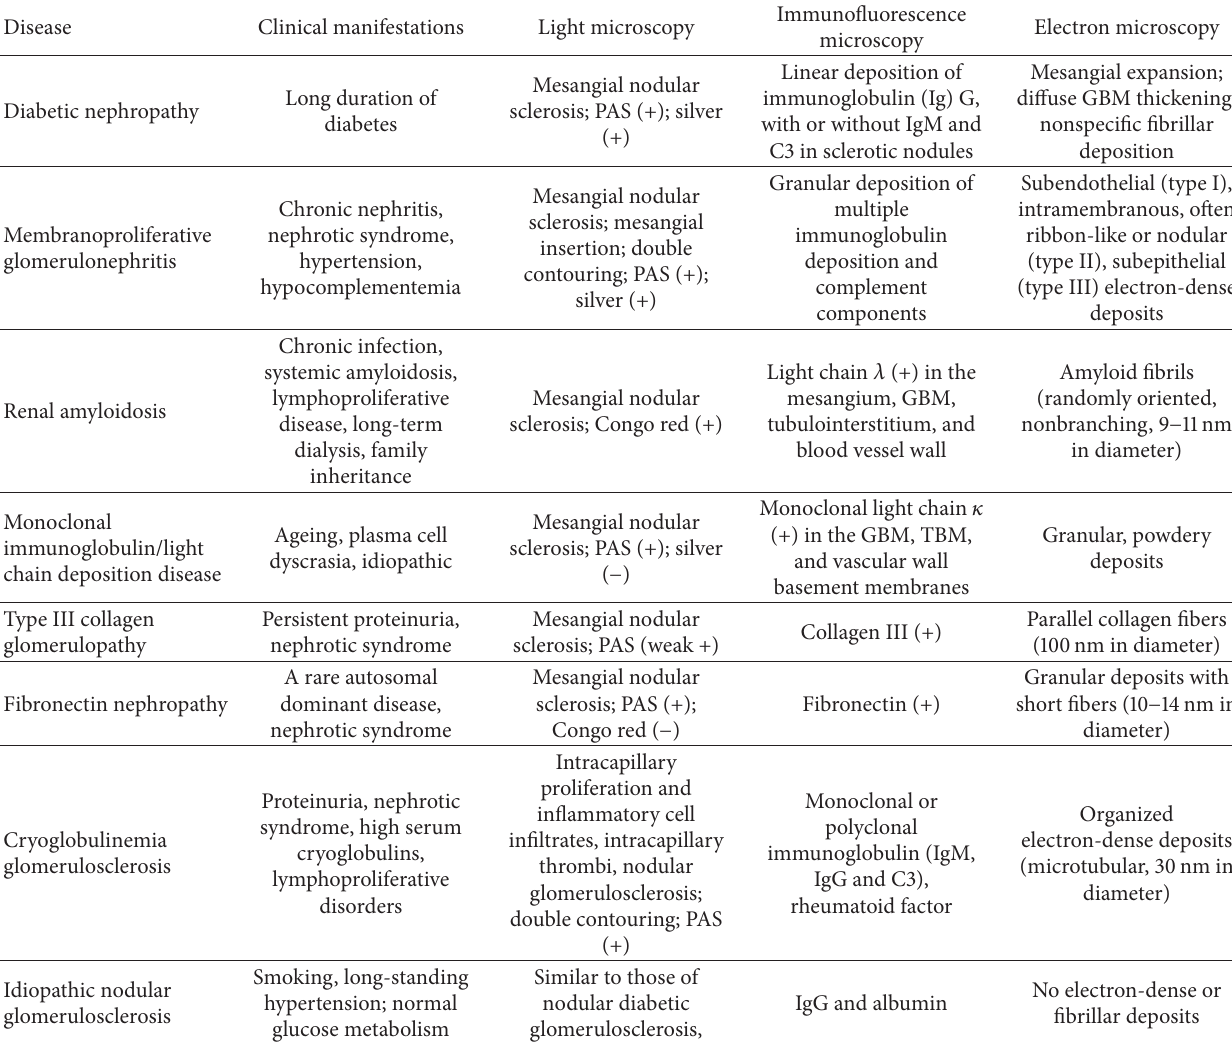
Table 3: Differential diagnosis of DN with another nodular